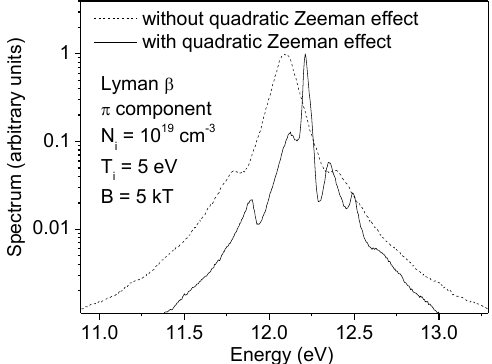
Figure 3. Plot of the π component of Lyman β , obtained from one calculation neglecting the quadratic Zeeman effect (dashed line) and one calculation retaining the quadratic Zeeman effect (solid line). In Zeeman e ff ect (dashed line) and one calculation retaining the quadratic Zeeman e ff ect (solid line). In both cases, the Stark broadening due to ions only is retained and the overlap with neighboring lines has not been included for the sake of clarity. The spectrum is split in many components when the quadratic Zeeman is